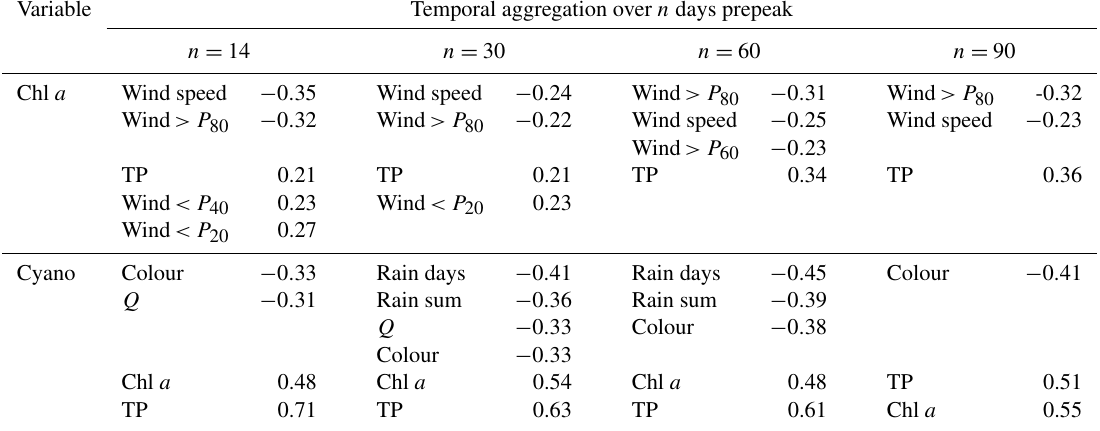
Table A1. Pearson’s R correlation coefficients for seasonal maxima of chl a and cyanobacteria and potential explanatory variables aggregated (mean or sum) over n days before the algal peak occurred. For clarity, only | R | > 0 . 20 are shown for chl a and | R | > 0 . 30 for cyanobacteria. Variable Temporal aggregation over n days prepeak